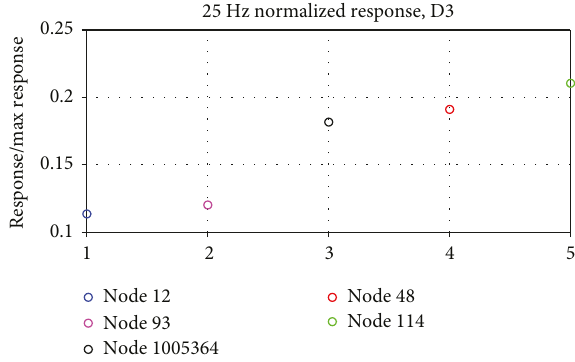
Figure 23: D3, 25 Hz normalized responses, double excitation